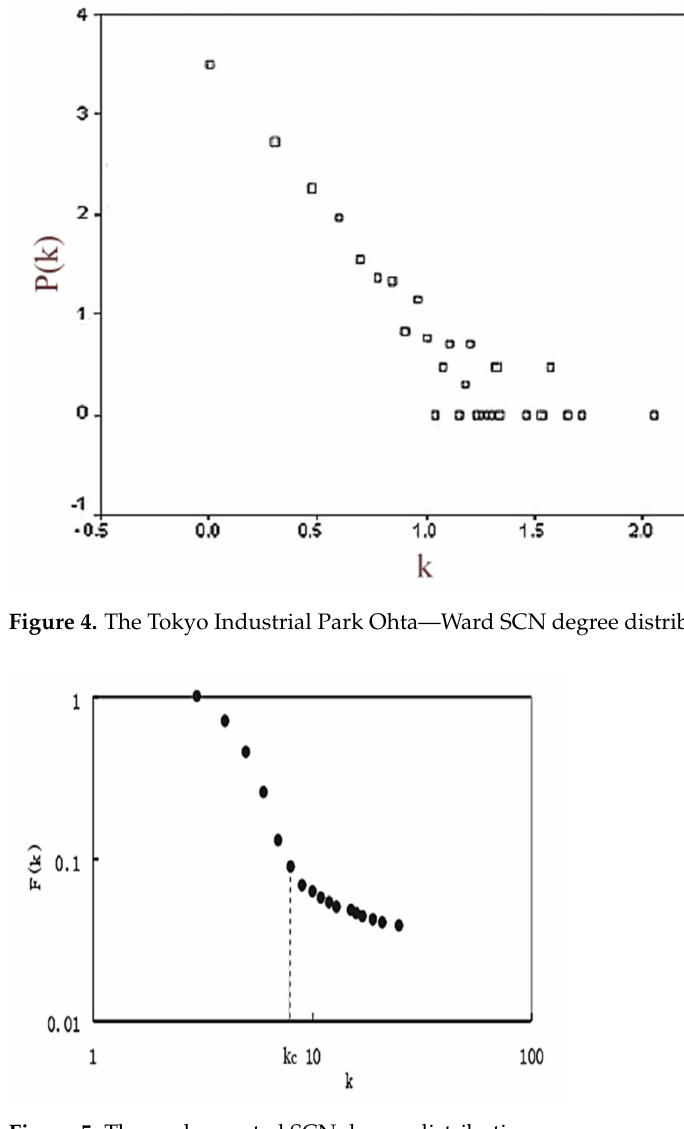
Figure 5. The agglomerated SCN degree